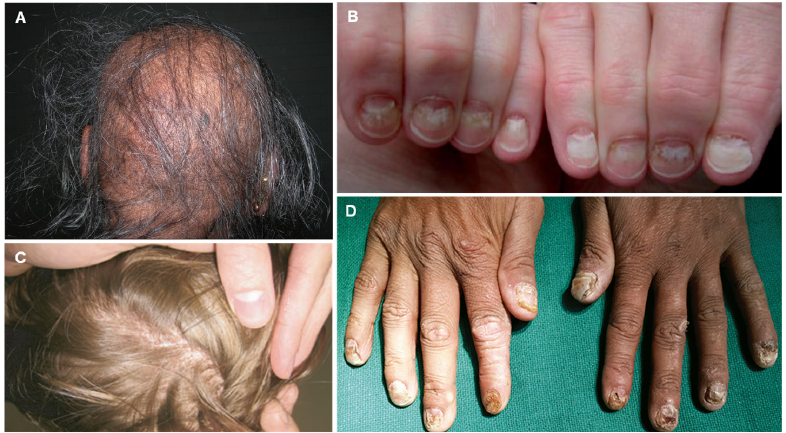
Figure 7. Patchy loss of hair over scalp ( A ). Nail dystrophy 43 days after cessation of the exposure ( B ). Red ‐ brown discoloration of the vertex scalp ( C ). Dystrophy of fingernails ( D ). Reprinted from ( A )—[210], ( B )—[211] ( C )—[212], ( D )—[209].